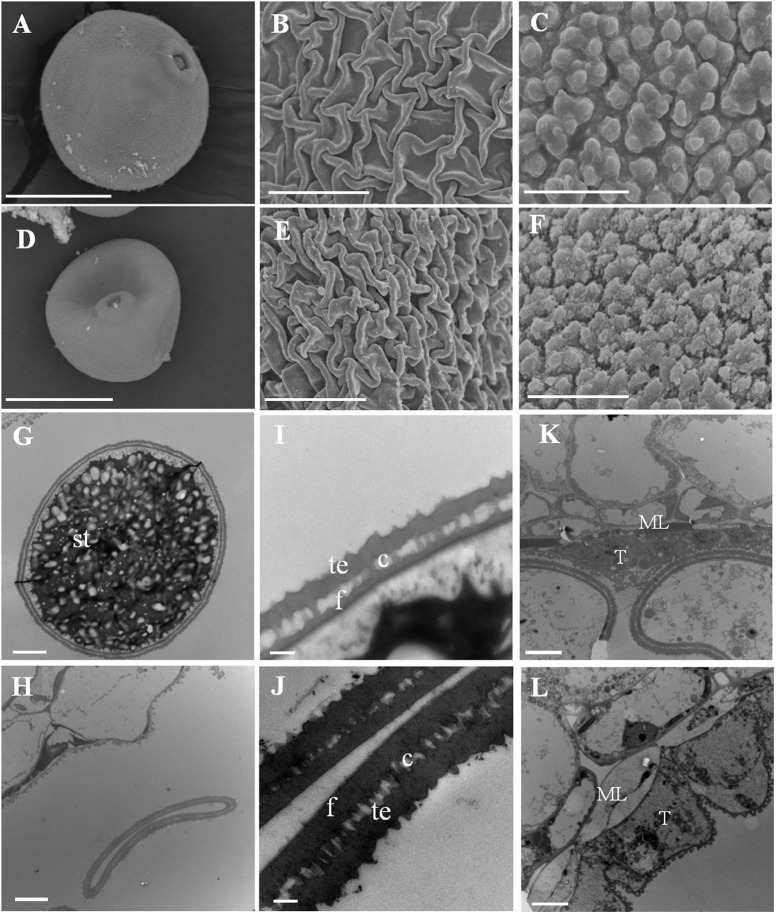
Scanning electron microscopy (SEM) and transmission electron microscopy (TEM) observation for WT and Osfignl1 mutant anther. (A) Scanning electron microscopy image of the mature WT pollen grain. (B) Scanning electron microscopy image of the WT anther epidermis. (C) Scanning electron microscopy image of the WT pollen exine. (D) Scanning electron microscopy image of the Osfignl1 pollen. (E) Scanning electron microscopy image of the Osfignl1 anther epidermis. (F) Scanning electron microscopy image of the Osfignl1 pollen exine. (G) Transmission electron microscopy showing the WT pollen. (H) Transmission electron micrograph showing the Osfignl1 pollen. (I) A higher magnification image of the WT pollen wall from (G). (J) A higher magnification image of the Osfignl1 mutant pollen grain from (H). Transmission electron micrographs of the WT (K) and Osfignl1 mutant anther (L) at bicellular pollen stage. c, columella; f, foot layer; te, tectum; st, starch granules; T, tapetum; ML, middle layer; Bars = 20 μm (A,D), 1 μm in (C,F), 5 μm in (B,E,G,H), 500 nm in (I,J), and 5 μm in (K,L).